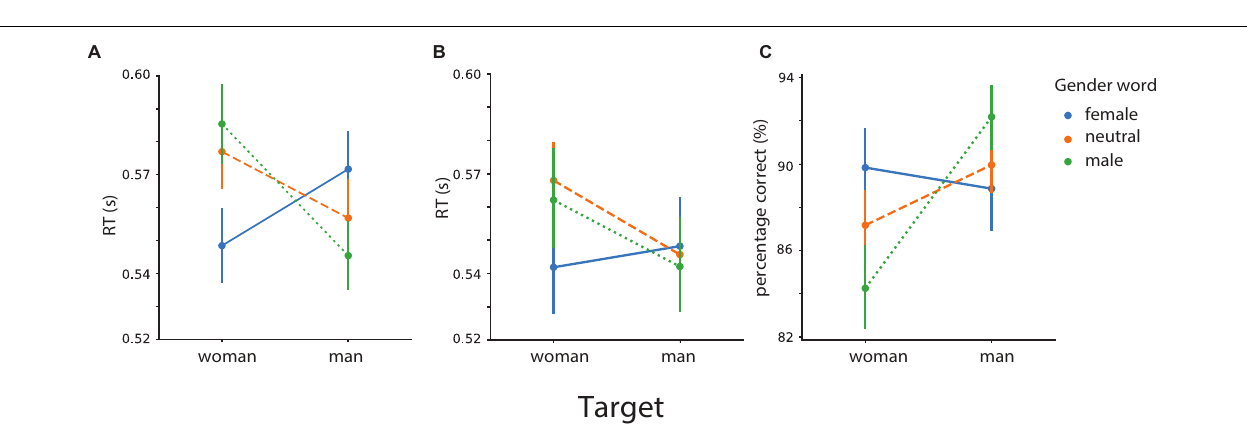
FIGURE 7 | Mean reaction times for gender categorization of the target as a function of identity words (“man”/“woman”) (A) and associations (“beard”/“skirt”) (B) . Percentage of correct responses (C) . Error bars represent 95% confidence interval (CI); RT, response time.